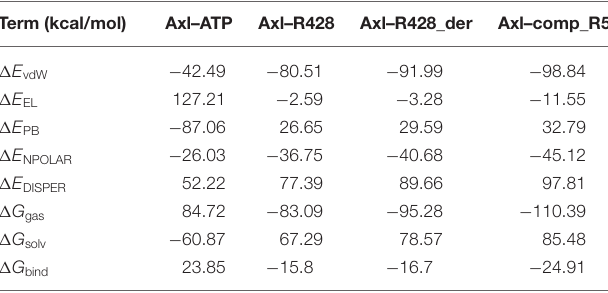
TABLE 8 | Energetic analysis of the receptor–ligand complexes using the MM-PBSA implicit solvation model.